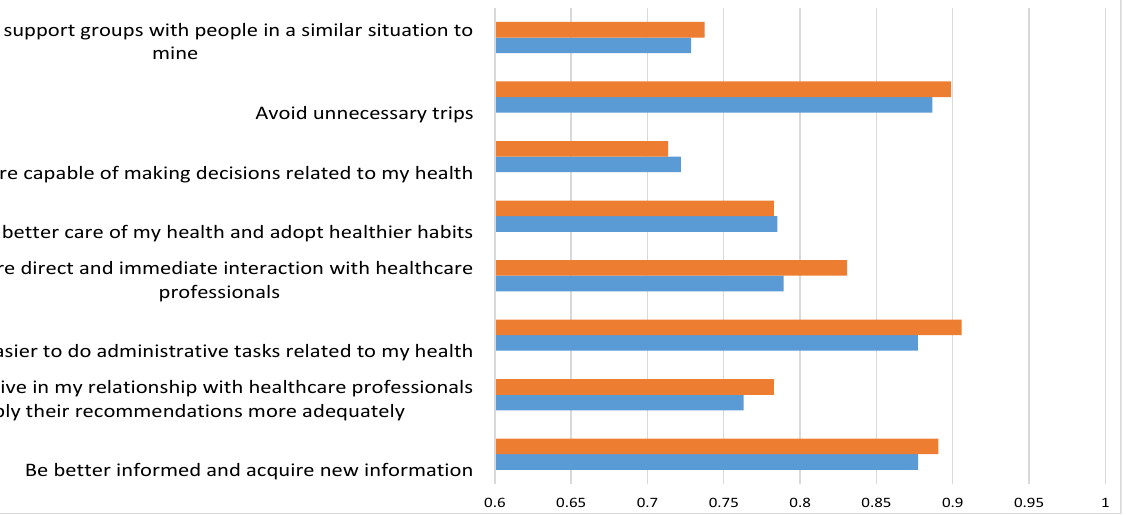
Figure 3. Rating of the potential of new technologies in health-related actions (by user profile).